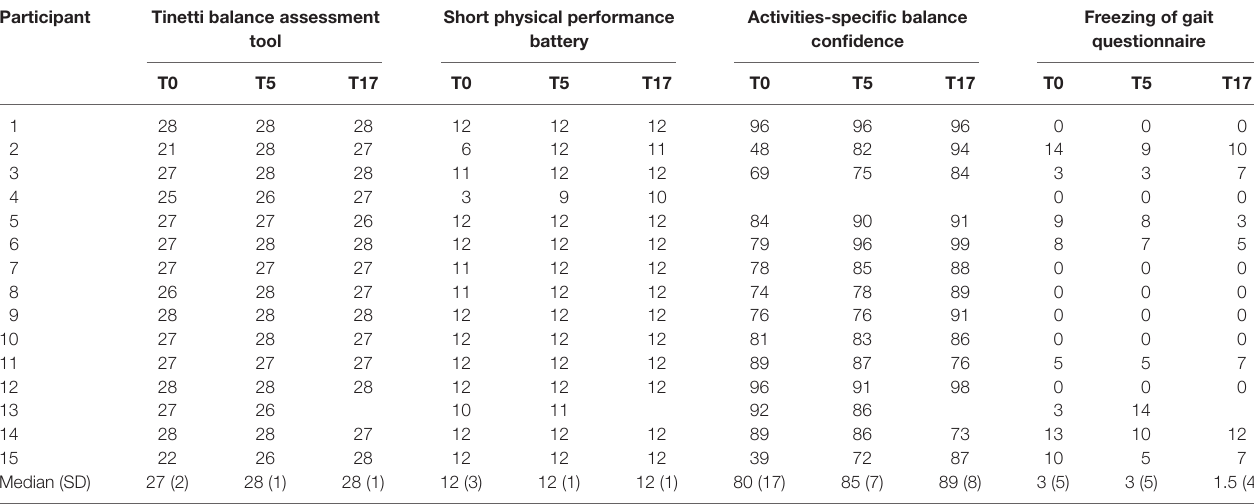
Empty cells indicate unassessed data.